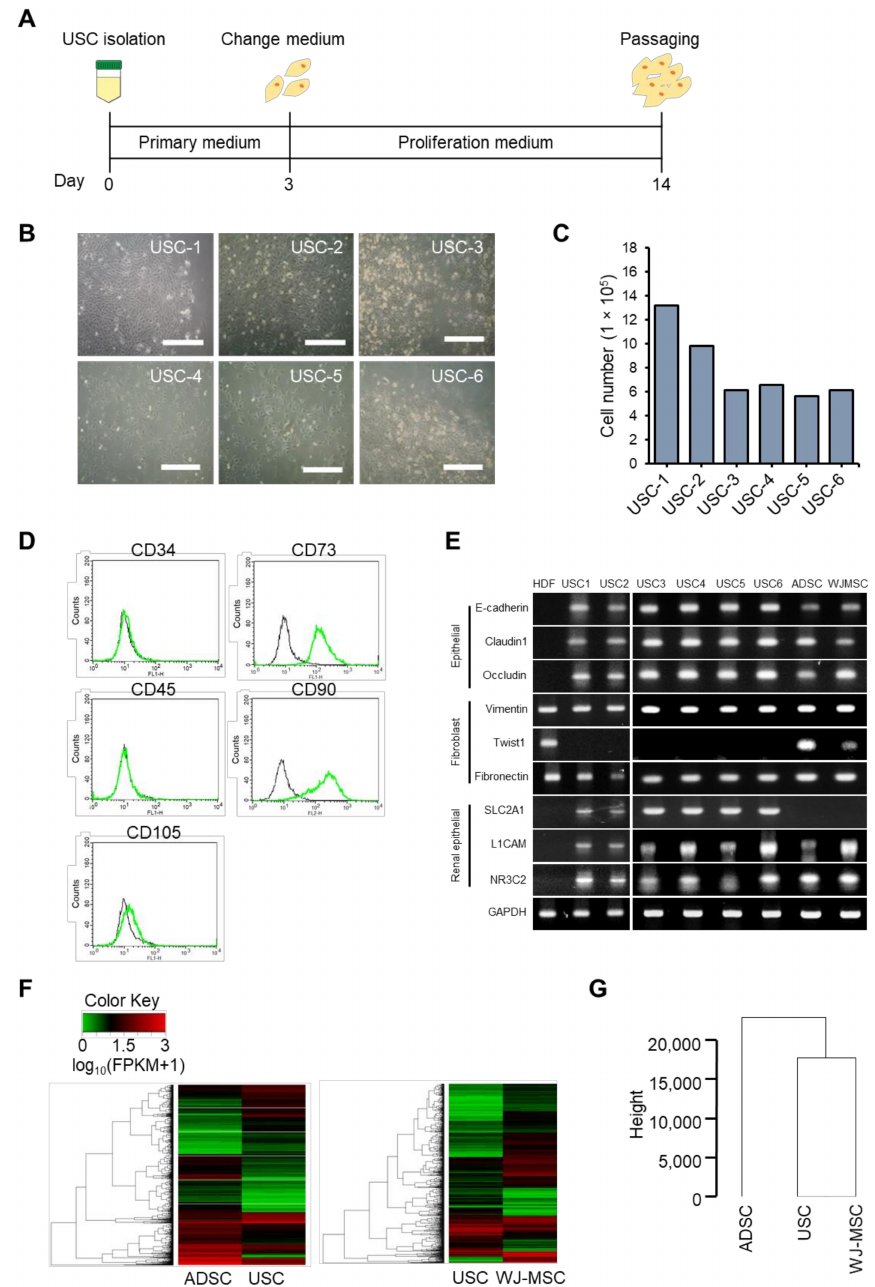
Figure 1. Characterization of urine stem cells (USCs). ( A ) Scheme of USC isolation. ( B ) Morphology of USCs from di ff erent donors after isolation (USC-1, 32-year-old male; USC-2, 50-year-old male; USC-3, 24-year-old male; USC-4, 22-year-old female; USC-5, 15-year-old female; USC-6, 20-year-old male). Scale bar: 400 µ m. ( C ) Number of USCs at 14 days in the 6 urine samples. ( D ) Representative flow cytometric analysis of USC populations. ( E ) RT-PCR analysis of fibroblast markers (vimentin, twist1, fibronectin), epithelial markers (E-cadherin, claudin 1, occludin), renal epithelial markers (SLC2A1, L1CAM, NR3C2), and urothelial markers (CK13, CK20, UPK1a, UPK3a). ( F ) RNA sequencing of USCs, adipose derived stem cells (ADSCs), and Wharton’s jelly-derived mesenchymal stem cells (WJ-MSCs). Heatmap of hierarchical clustering of DEGs between of ADSCs, WJ-MSCs, and USCs (Fold change ≥ 2, p -value ≤ 0.05). ( G ) Dendrogram of hierarchical clustering group analysis based on gene expression profiles to show the similarities among the USCs, ADSCs, and